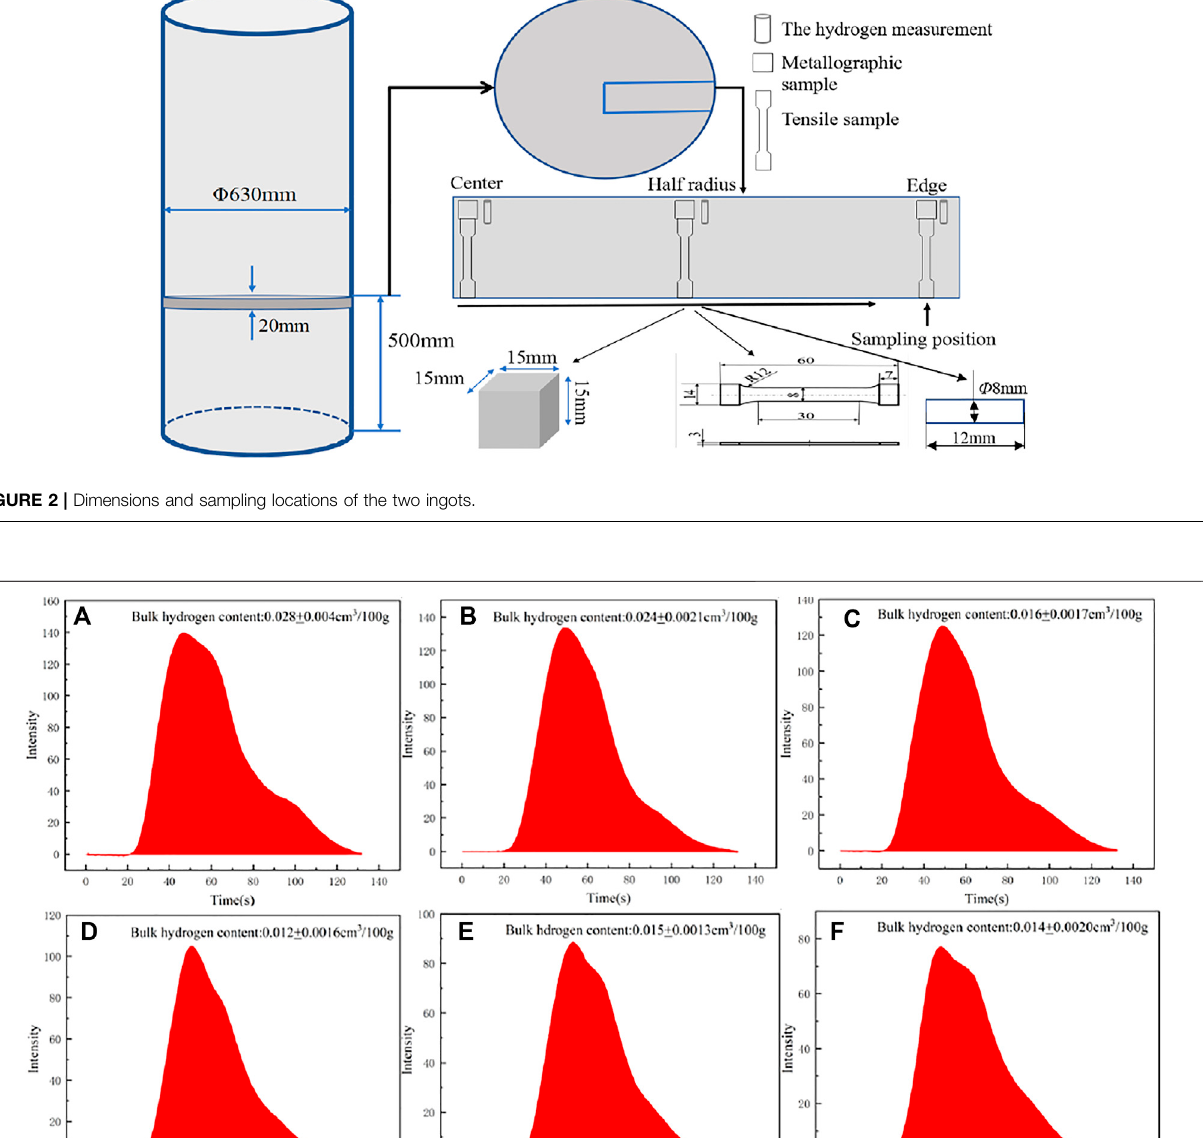
Frontiers in Materials |